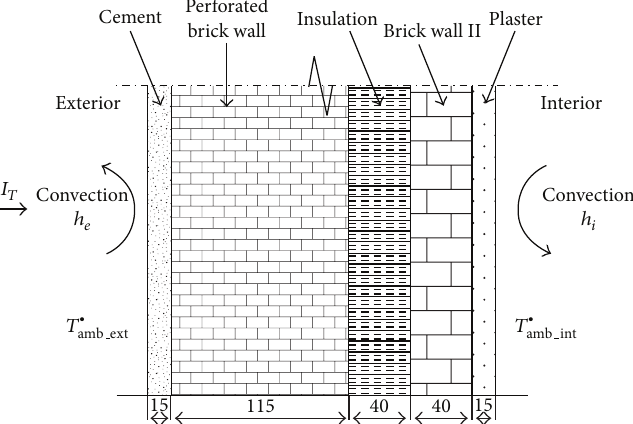
Figure 2: A schematic diagram showing the wall layers of the typical external wall (base composite wall) used in the simulations.